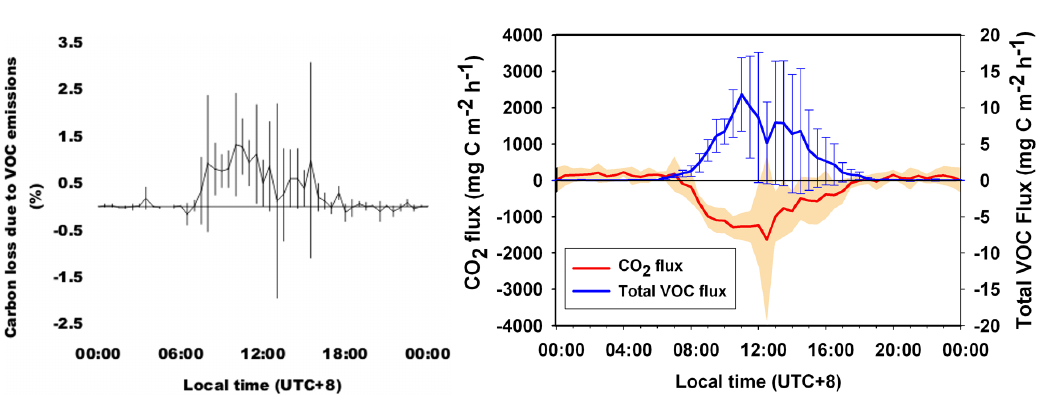
Fig. 9. (a) Net canopy carbon loss due to BVOC emissions at oil palm; (b) Diurnal trend of total VOC flux in comparison with CO2 flux. The datasets correspond to the same 2 week